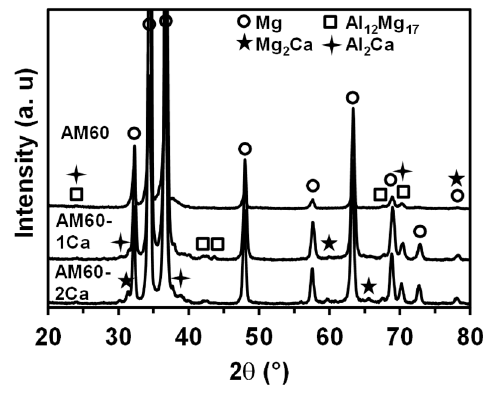
Figure 3. X-ray diffraction (XRD) patterns of the AM60, AM60-1Ca, and AM60-2Ca substrates.